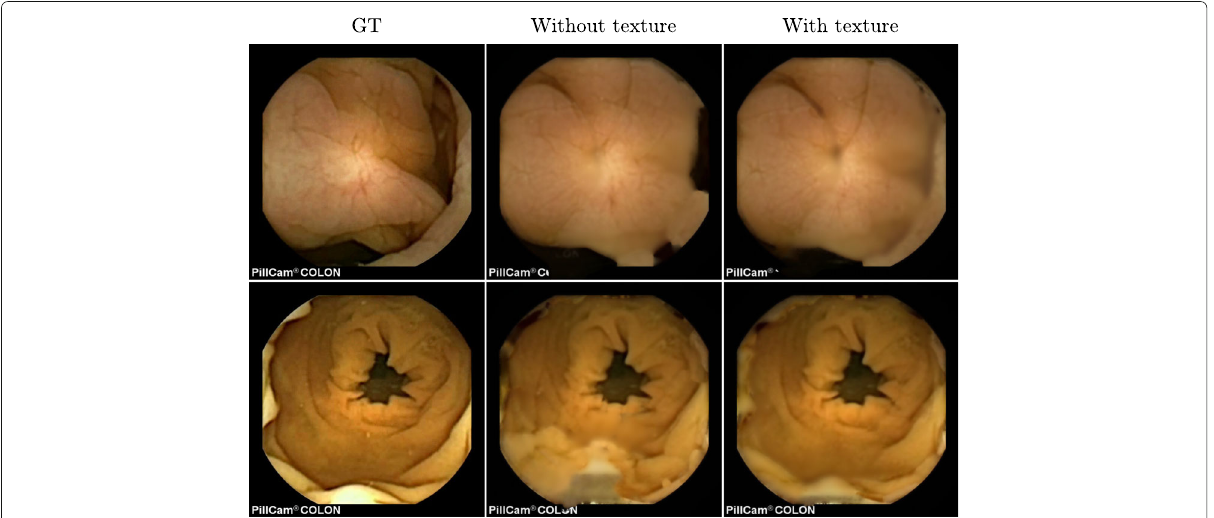
Fig. 6 Visual comparison of proposed method with and without textural feature constraint for sample frames from seq3 and seq4. First column shows the ground truth frame 8 and 12 from seq3 and seq4. The second column and third column show interpolation result using frames 7 and 9 and frames 11 and 13 with texture and without textural feature constraints